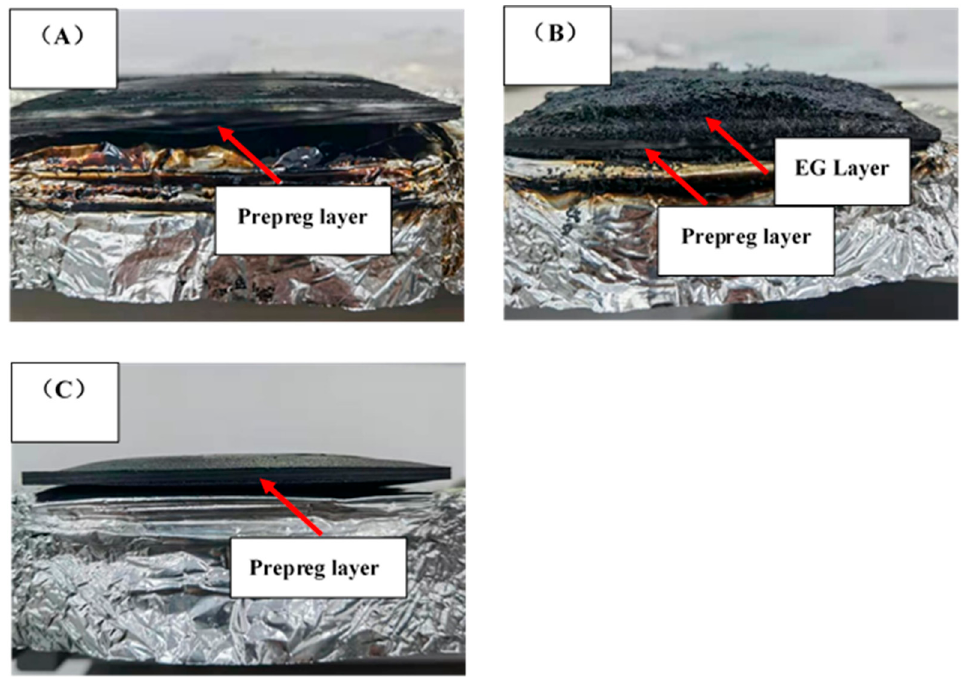
Figure 7. Fracture images after cone calorimeter tests: ( A ) Laminate 1; ( B ) Laminate 2; ( C ) Laminate 3.